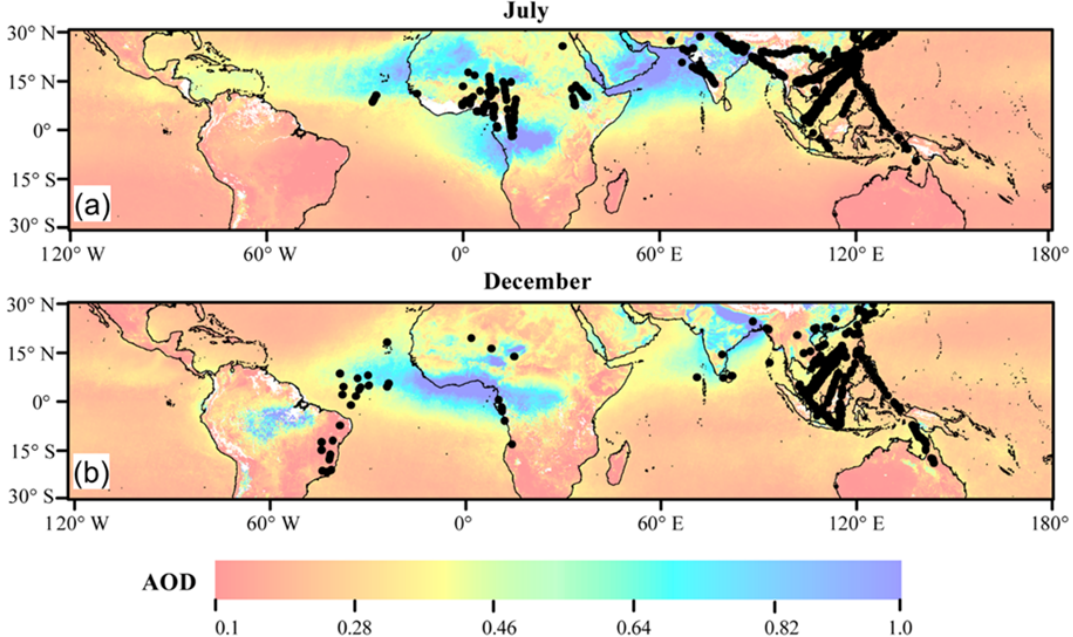
Figure 10. Spatial distribution of the aerosol optical depth (AOD) derived from MODIS on the Aqua satellite (nadir pass at 13:30LT) for (a) July and (b) December 2011–2019. The EIEs for July and December are shown as black markers. The AOD has been normalized so that the maximum value is unity. The few white regions correspond to grid points with a very high fraction of clouds so that a valid retrieval of AOD is not